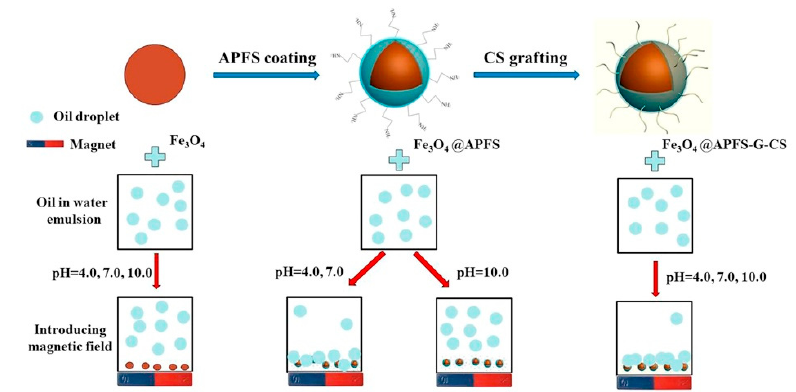
Figure 2. Schematic representation of the e ffi cient removal of oil droplets from emulsified oil wastewater with aminopropyl-functionalized silica (APFS) coated, chitosan-grafted magnetic nanoparticles. An enhanced demulsification e ff ect was observed after grafting with chitosan under all the tested pH conditions. Reproduced with permission from Reference [26] Copyright © 2017